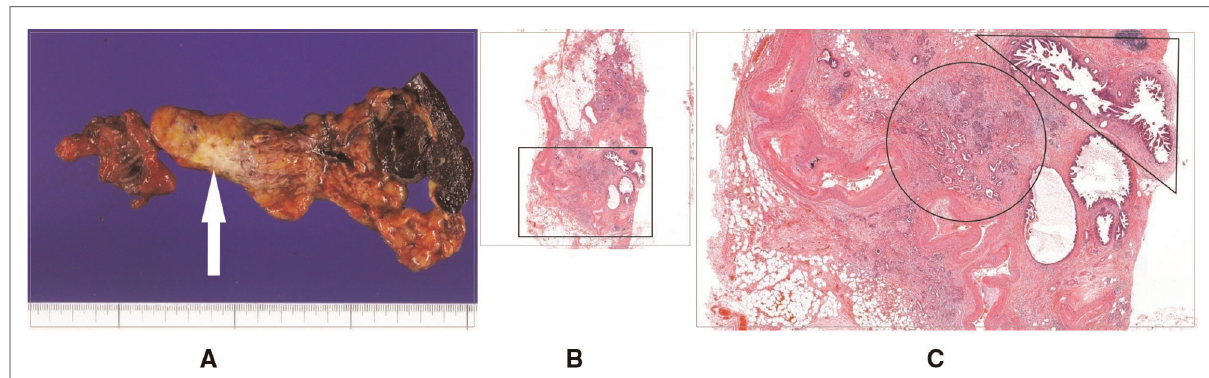
FIGURE 4 ( A ) Gross specimen of completion total pancreatectomy comprising the remnant pancreas body, spleen, and a jejunal segment including pancreaticojejunostomy, with the white arrow indicating cancer. ( B ) Histologic fi ndings of the pancreas body including cancer. ( C ) Magni fi ed image of the black square in ( B) , showing pancreatic ductal adenocarcinoma cells (black circle) and multiple lesions of low grade to a high degree of pancreatic intraepithelial neoplasia around the main lesion (black right